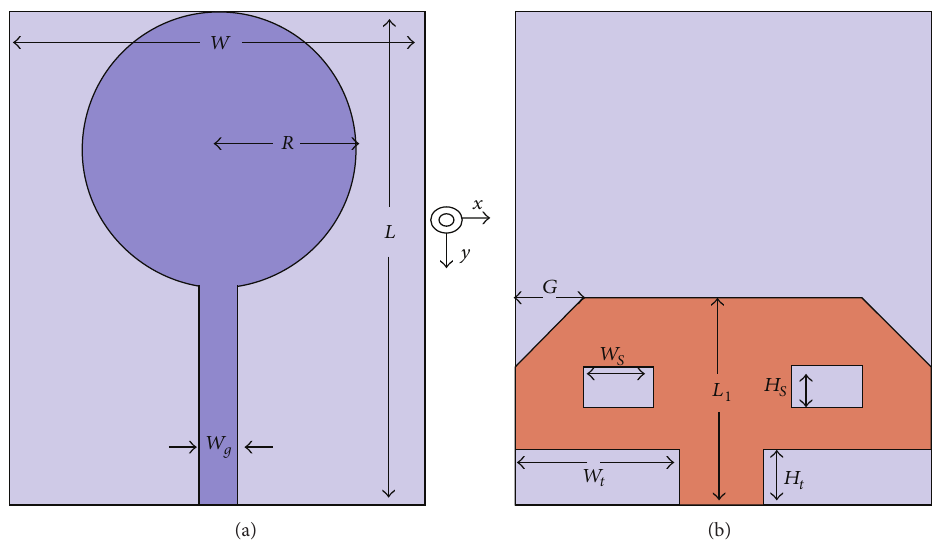
Figure 1: Geometry of the UWB antenna: (a) top view, (b) bottom view.